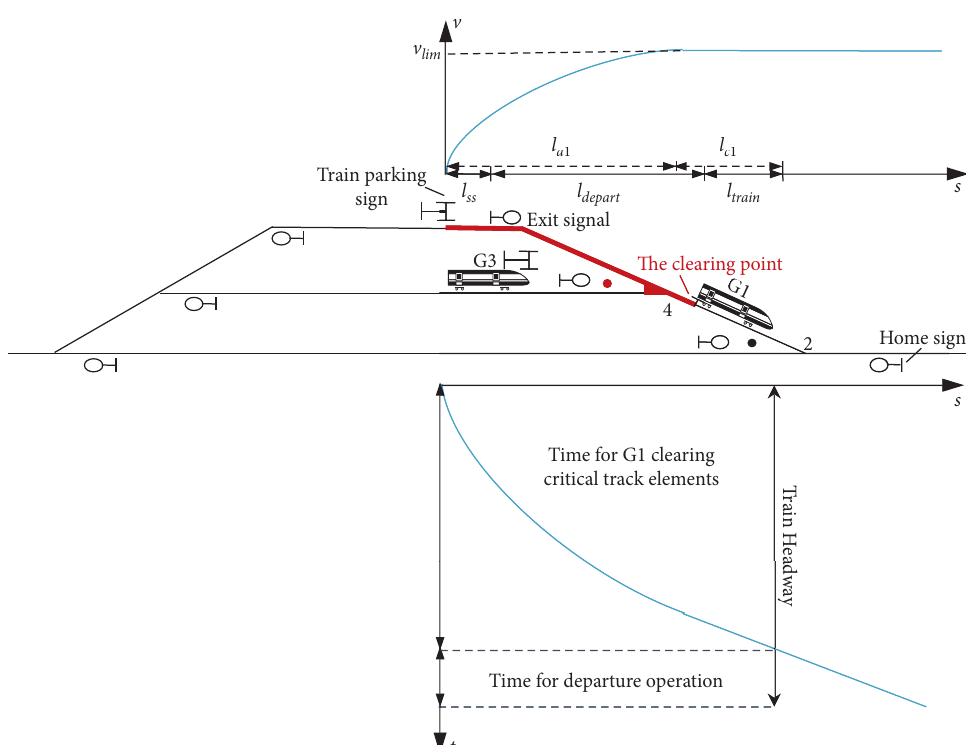
Figure 8: G1 and G3 both depart from the